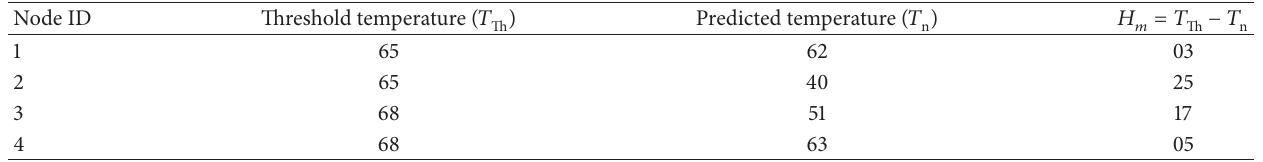
Table 8: Predict table